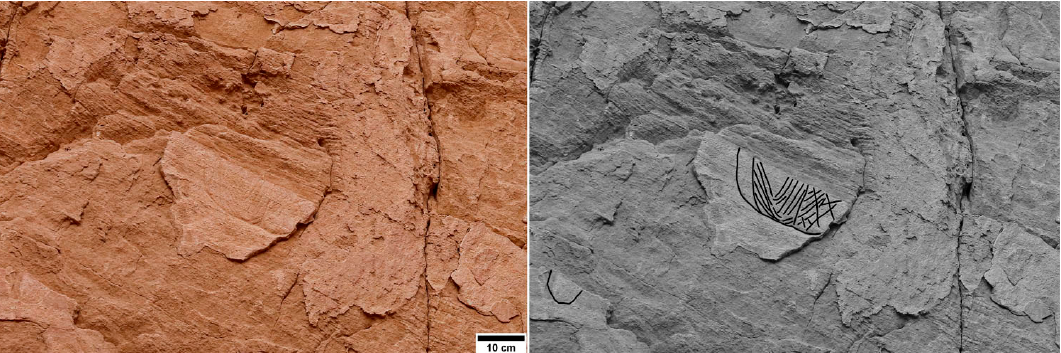
Figure 21. Two overlapping oval engravings (E8); the one in the foreground is decorated with an angled grid (black and white version: interpretation by tracing, Photo: Alessandro Menardi Noguera).